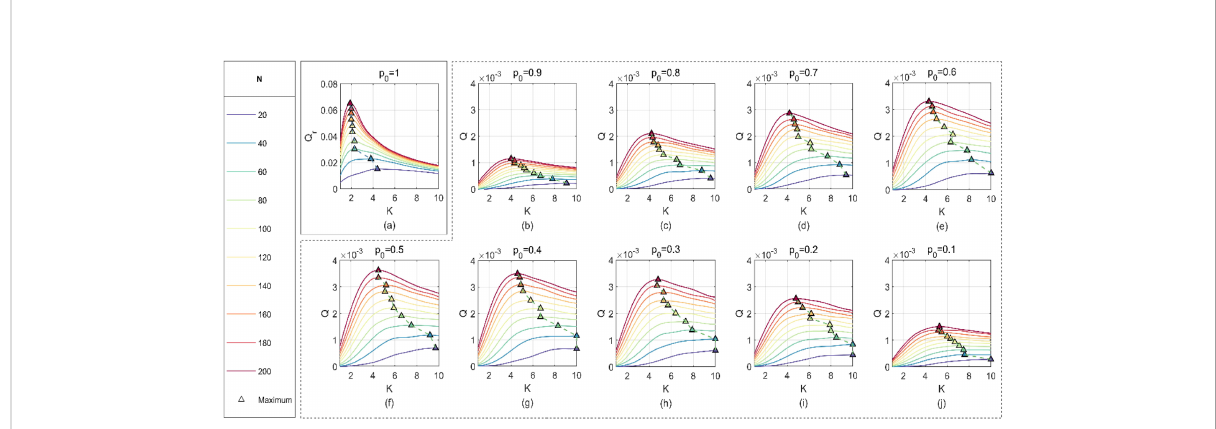
FIGURE 16 In fl uence of K on Q r and Q with different values of N and p 0. .